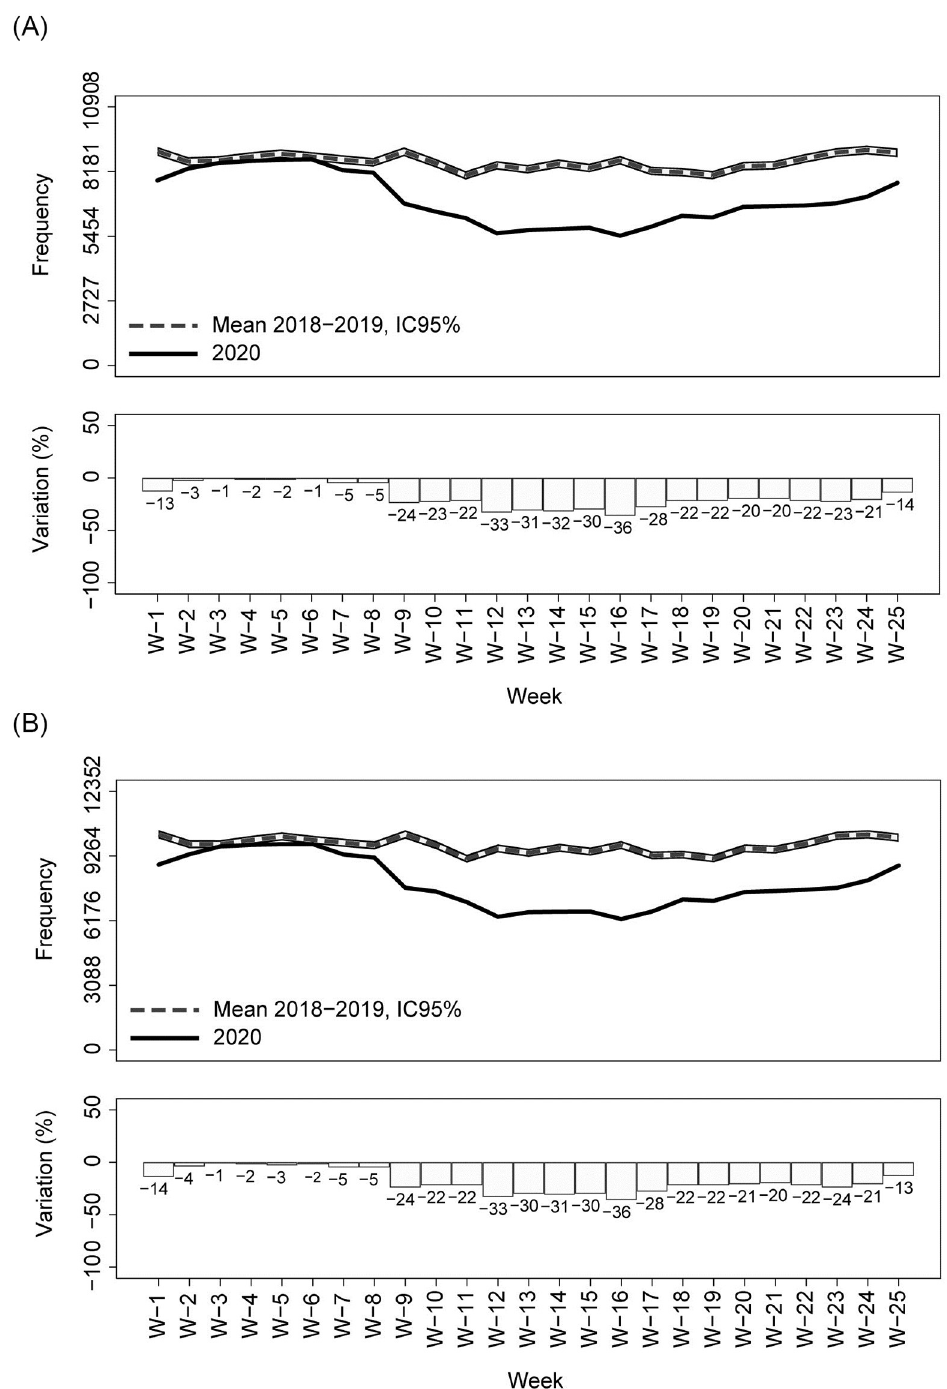
Fig 2. Utilization of out-of-hospital emergency medical services in Tuscany Region by week (year 2020 vs 2018– 19); percentage changes and 95% CIs. (A) Weekly frequency of calls for emergency medical assistance; percentage changes and 95% CIs. (B) Weekly frequency of mobile medical care units dispatched; percentage changes and 95% CIs.